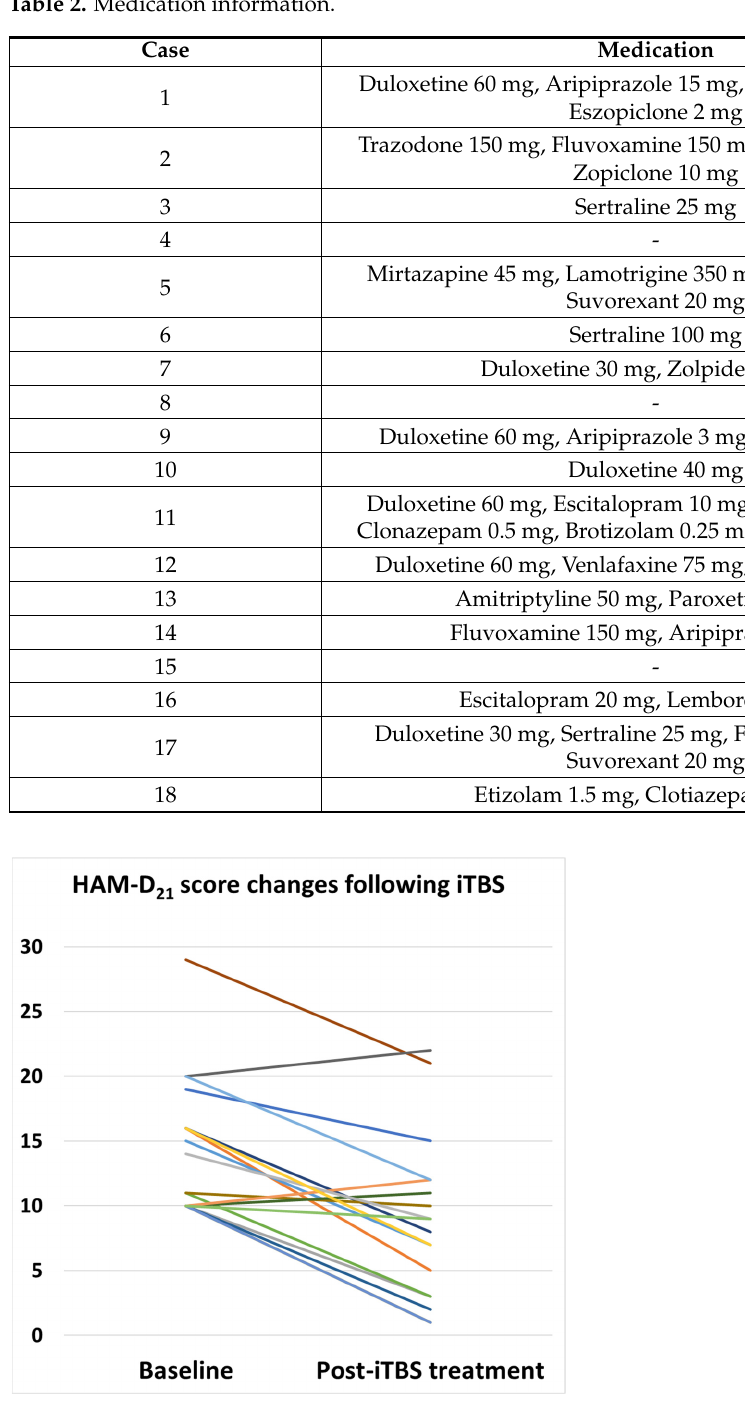
Figure 1. Longitudinal changes in HAM-D 21-item score following iTBS treatment for depressive symptoms in patients with ASD. Each color represents the score change for each